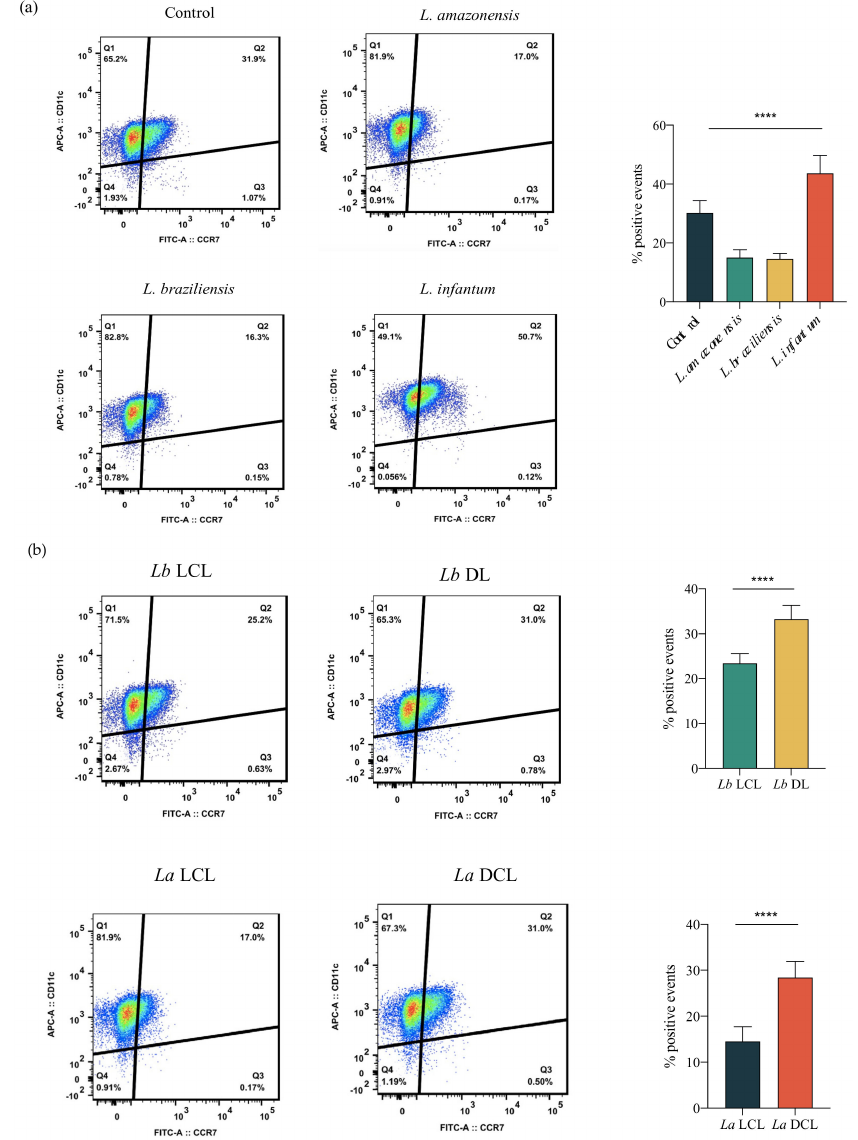
Figure 8. Infection using L. infantum, Lb DL and La DCL isolates induces CCR7 expression in hDCs. Representative gating strategy illustrating CCR7 expression by hDCs infected or not with isolates of different Leishmania species at 6 h post-infection, as assessed by flow cytometry. ( a ) CCR7 expression following DC infection with L. amazonensis , L. braziliensis or L. infantum . ( b ) CCR7 expression following DC infection with Lb (LCL), Lb (DL), La (LCL) or La (DCL). **** p < 0.001 (ANOVA). Data are representative of two independent